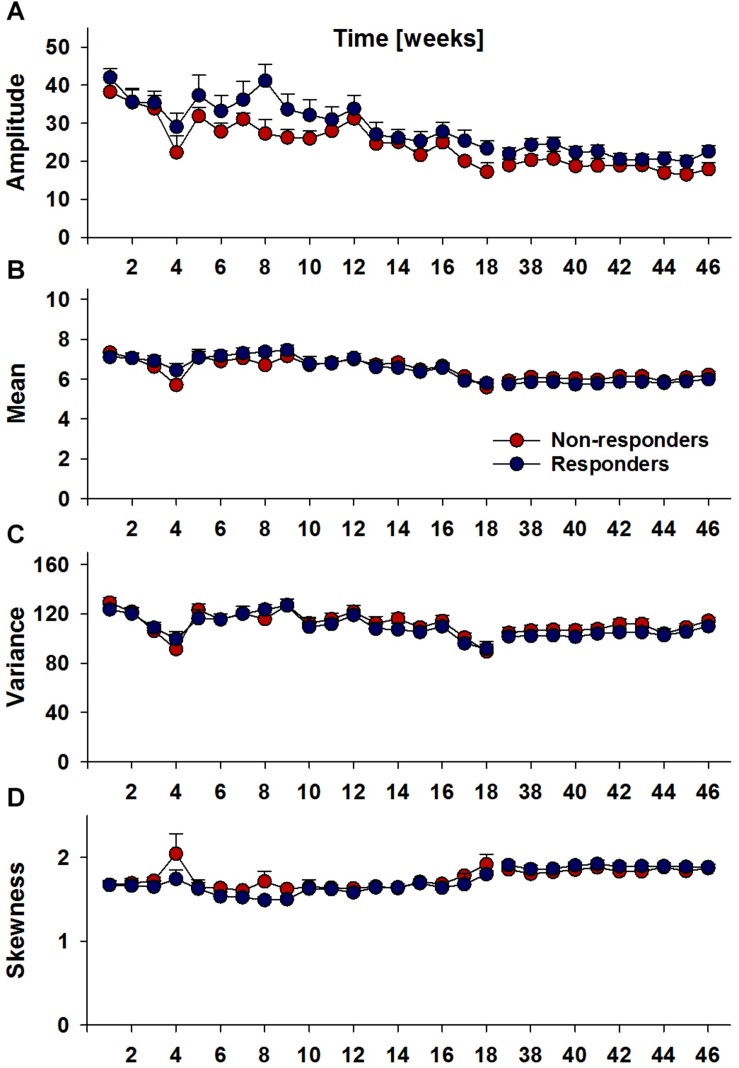
Longitudinal locomotor activity parameters, circadian amplitude (A), mean per-minute locomotor activity (B), variance (C) and skewness (D) per week in Responders (n = 17) and Non-Responders (n = 7). Analyses did not reveal significant group differences.